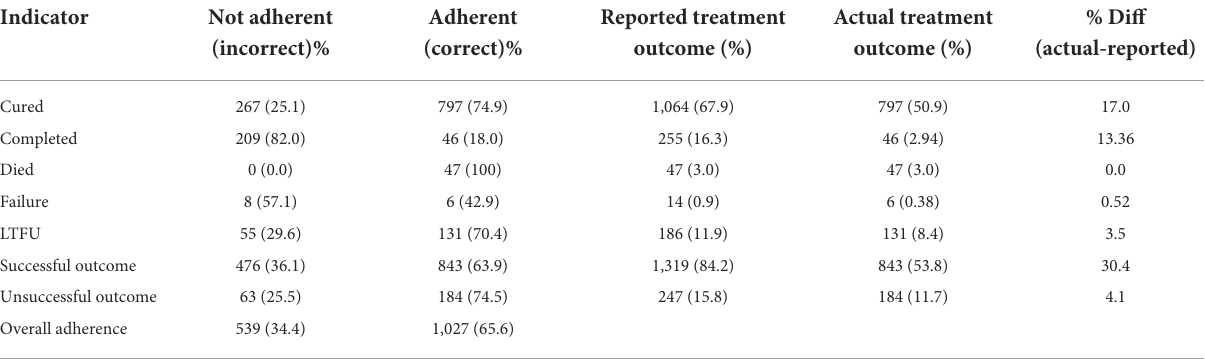
TABLE 3 Analysis of level of adherence to National TB Guideline in assigning various TB treatment outcomes ( n =